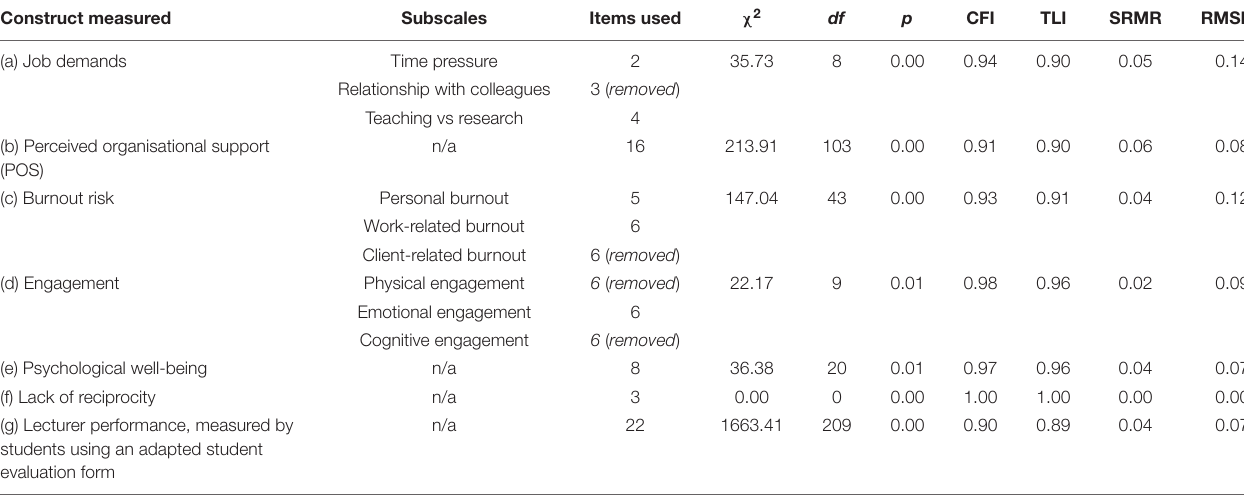
TABLE 2 | Fit statistics per measurement construct